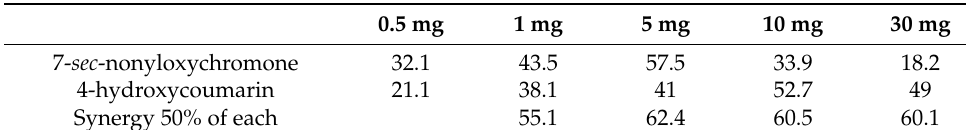
Table 21. Comparison of attractant effects of 7- sec -nonyloxychromone ( 12 ), 4-hydroxycoumarin, and synergy of these two compounds.